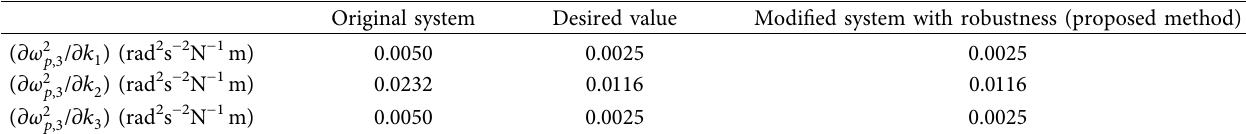
Table 12: Test-case 3: original, desired, and modified system sensitivities of